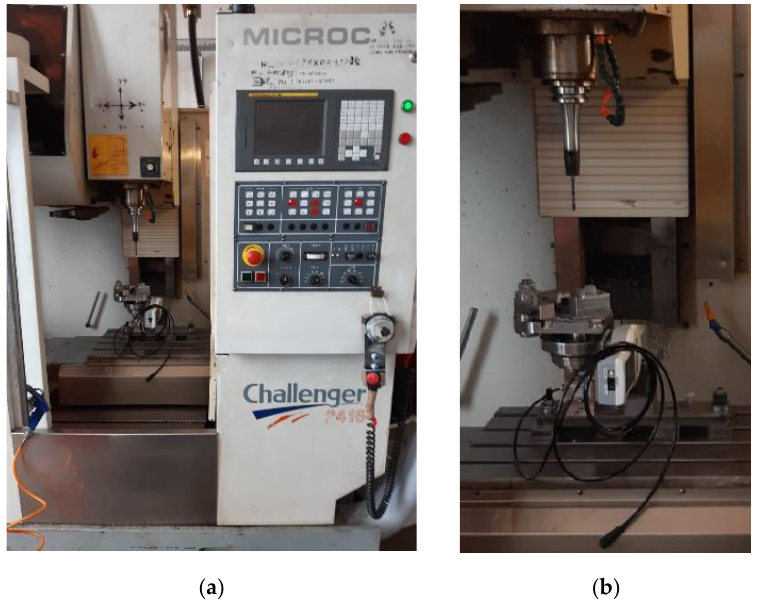
Figure 1. Challenger 2418 CNC machine ( a ) and specimen fixture and cutting tool ( b ).